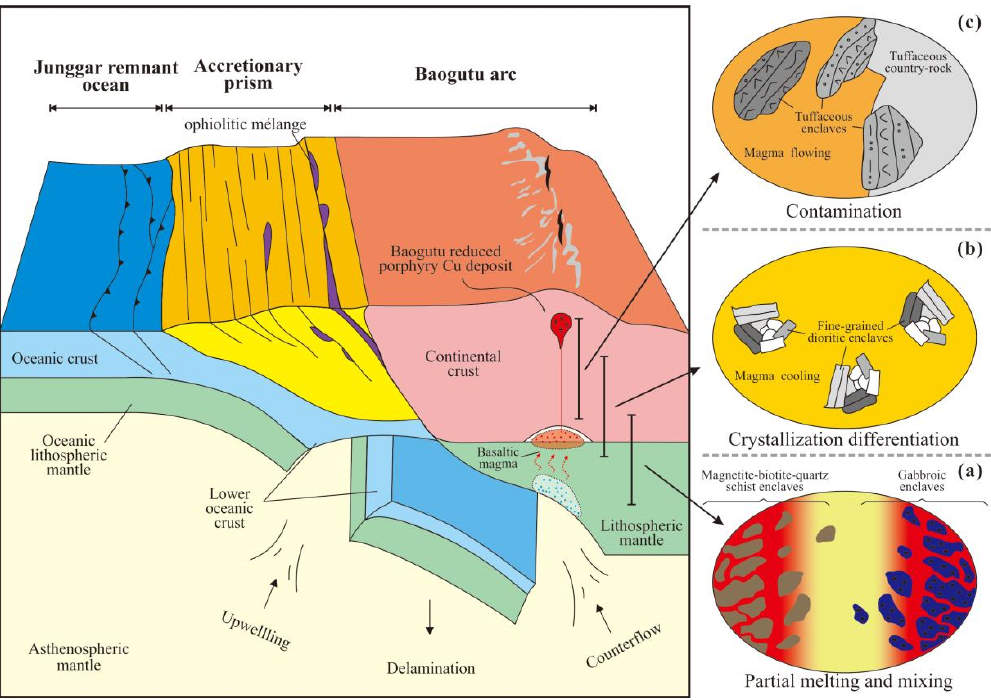
Figure 6. A simplified model to show the tectonic environment and magmatic process of the Baogutu reduced Cu porphyry-type deposit in West Junggar (modified from [45]). Panels ( a ), ( b ) and ( c ) show the multiple hypotheses of the enclaves’ origins in the Baogutu reduced Cu porphyry-type deposit.